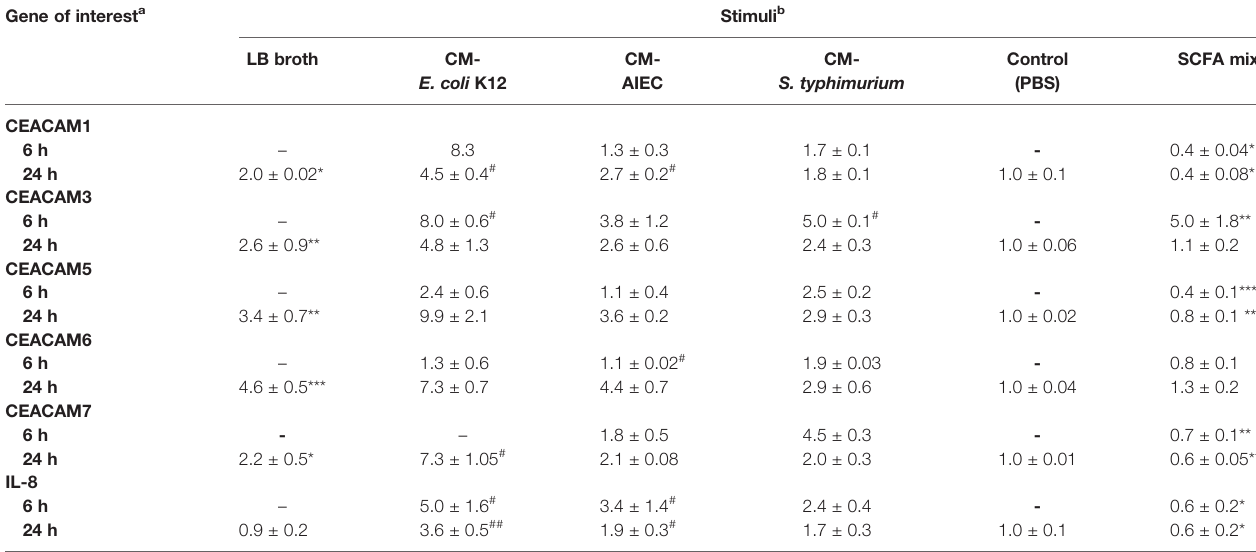
TABLE 1 | CEACAM expression in intestinal epithelial cells cultured with bacterial conditioned medium with bacterial conditioned medium and SCFA. Gene of interest a Stimuli